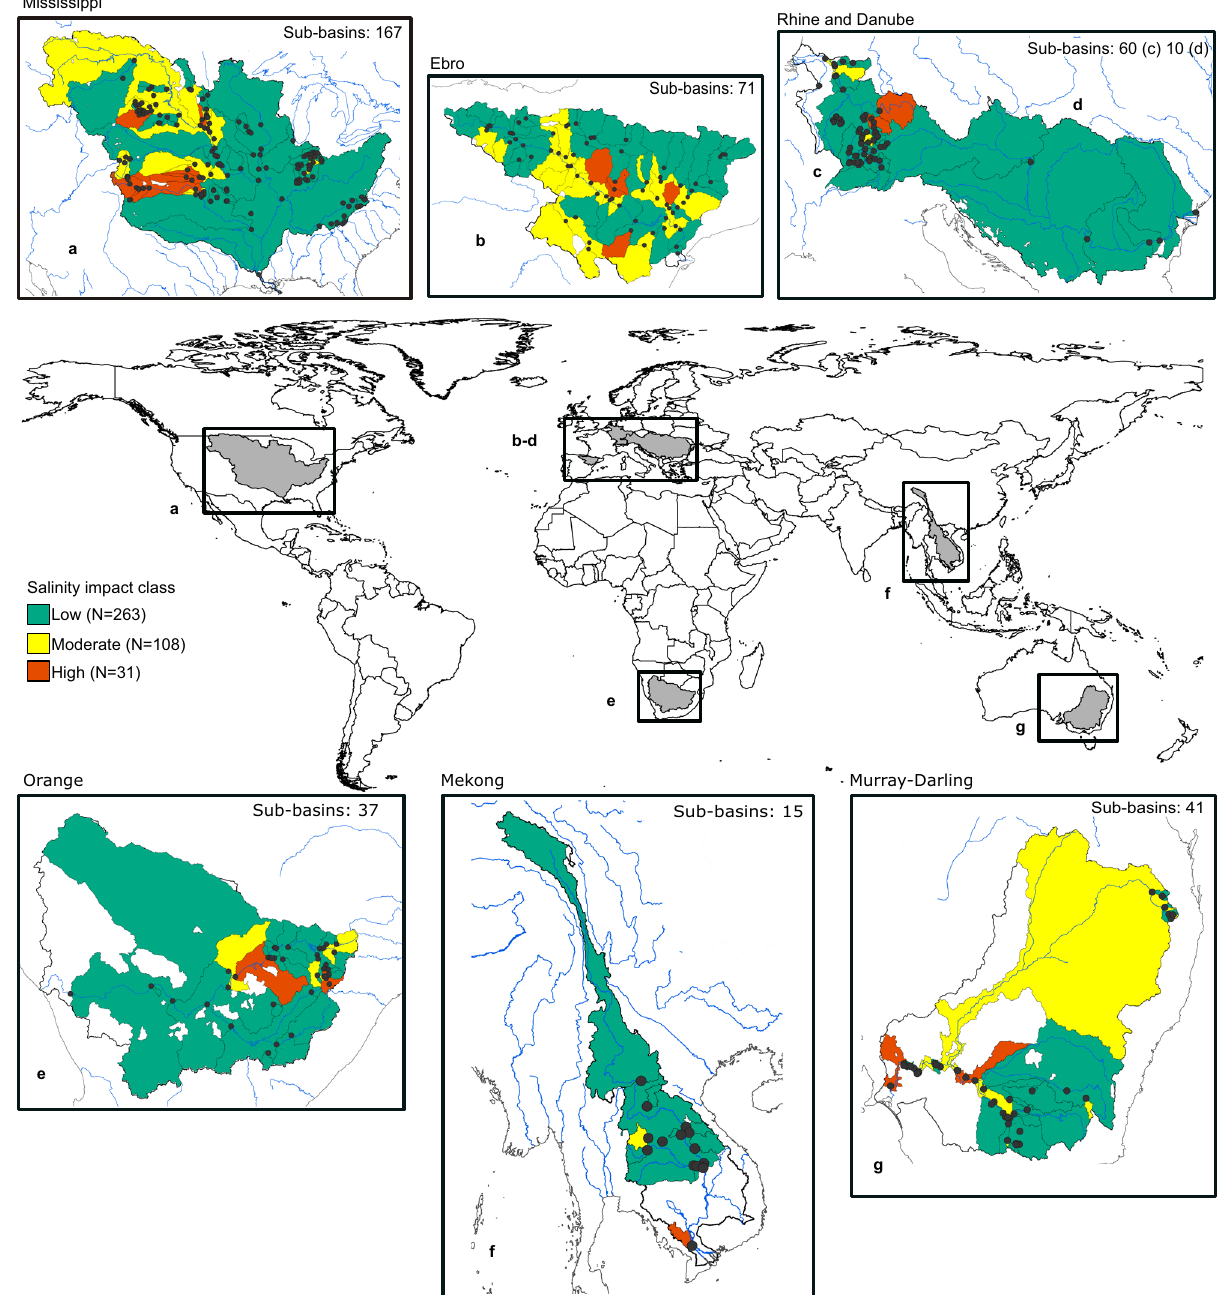
Fig. 2 Long-term average salinity levels across the studied river sub-basins. Overview of the seven selected regional river basins and associated delineated 401 sub-basins from monitoring locations (black dots), with number of sub-basins of each regional river basin given in each zoomed panel. The salinity (EC) data availability criteria per monitoring station is at least 15 years of monthly data over the 1980 – 2010 period. The full distribution of salinity measurements per station is given in Supplementary Fig. S1.2. Each sub-basin is classi fi ed into different salinity impact classes, based on thresholds for irrigation water use, with Low (EC < 700 µ S cm − 1 ; green colour), Moderate (<700 – 1500 µ S cm − 1 ; yellow colour) and High (>1500 µ S cm − 1 ; orange colour) classes and associate total number of sub-basins within each class (N), based on long-term annual average EC over the 1980 – 2010 period. Sub-basins in white did not meet the data criteria of stations with a minimum of 15 years of monthly salinity data within the study